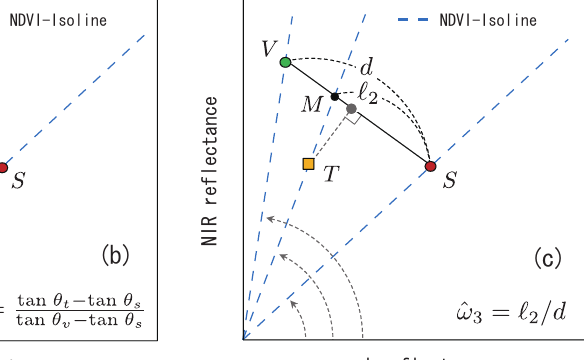
( i = 1 , 2) , and θ ) which i